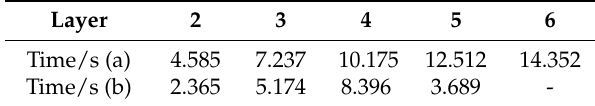
Table 1. The training time of the different hidden layers in Figure 10.